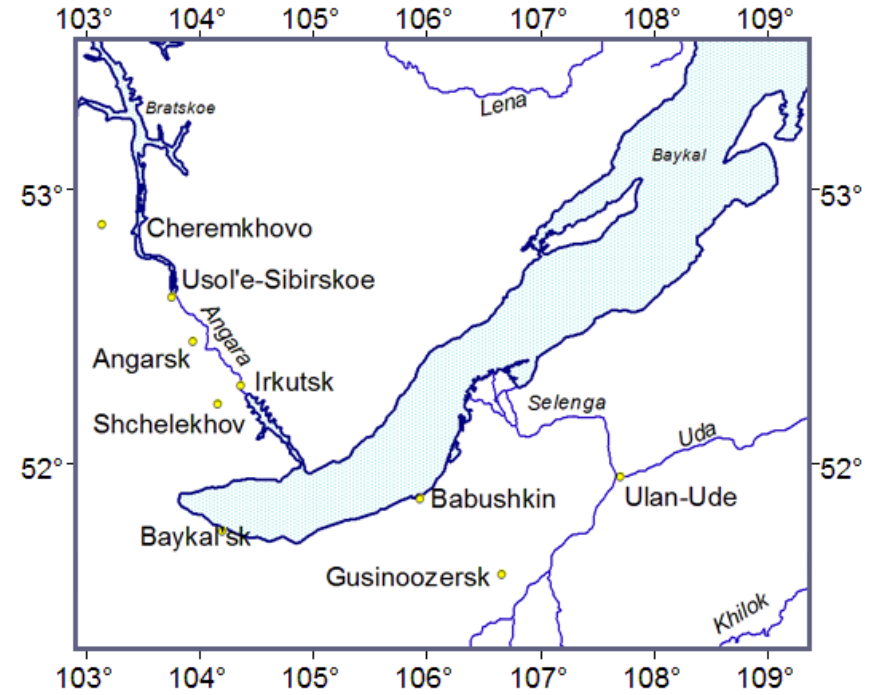
Figure 3. Considered region of the RF with the coordinates 51–54 ◦ N, 103–109 ◦ E.